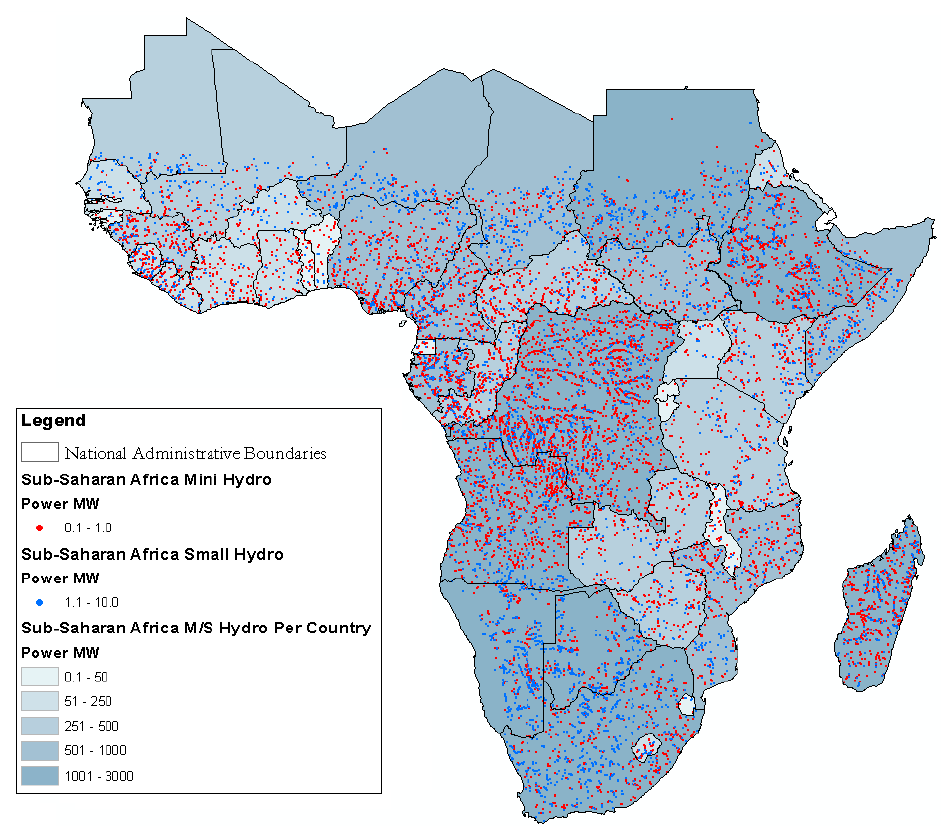
Figure 7. Map illustrating the hydropower potential sites identified for capacities between 0.1 and 10 MW in Sub-Saharan Africa.